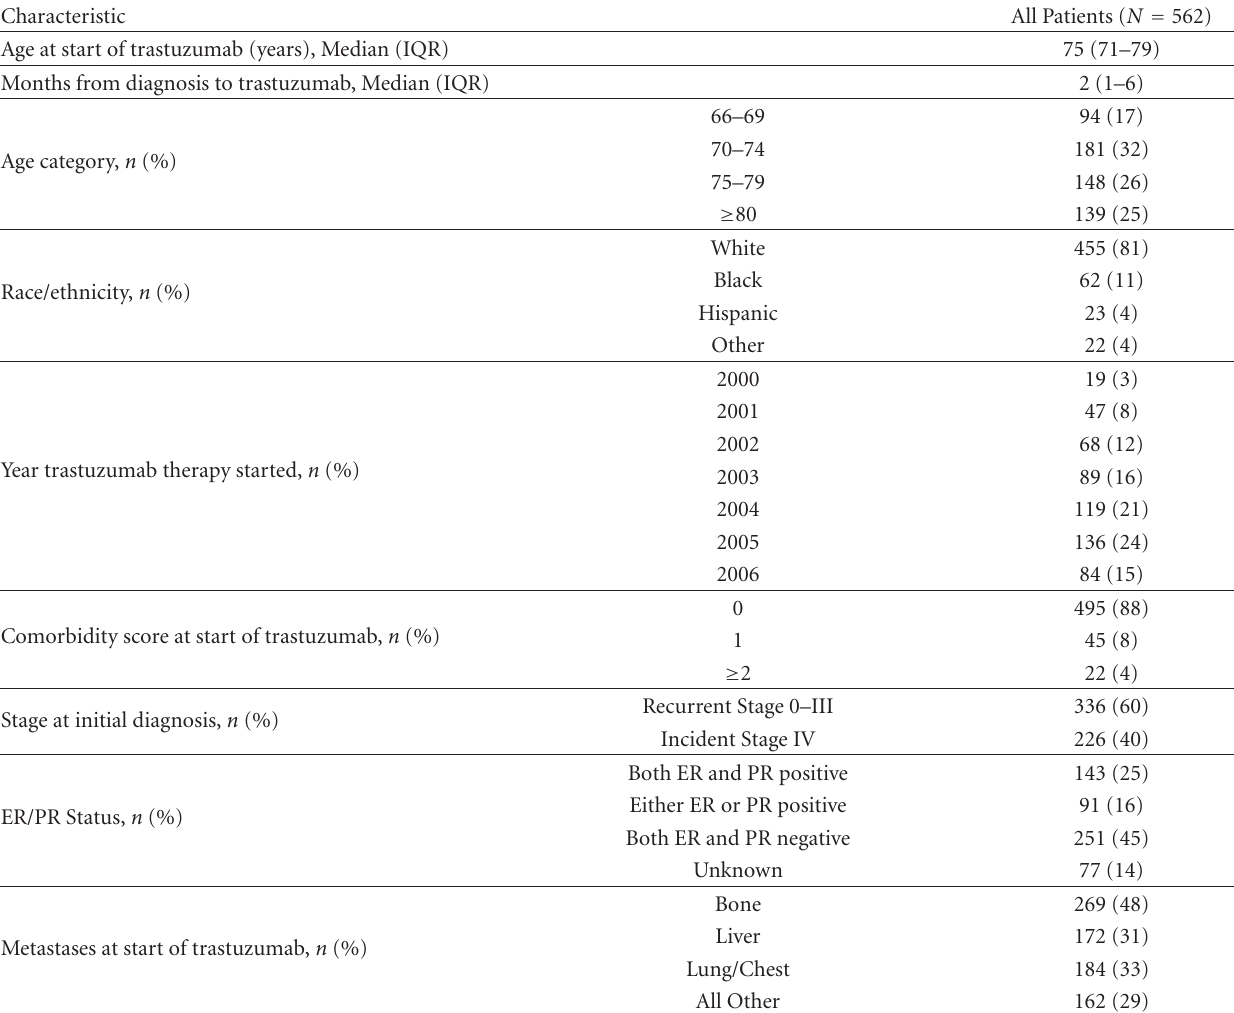
Table 1: Characteristics of patients without CNS metastases at the time of starting trastuzumab for metastatic breast cancer.